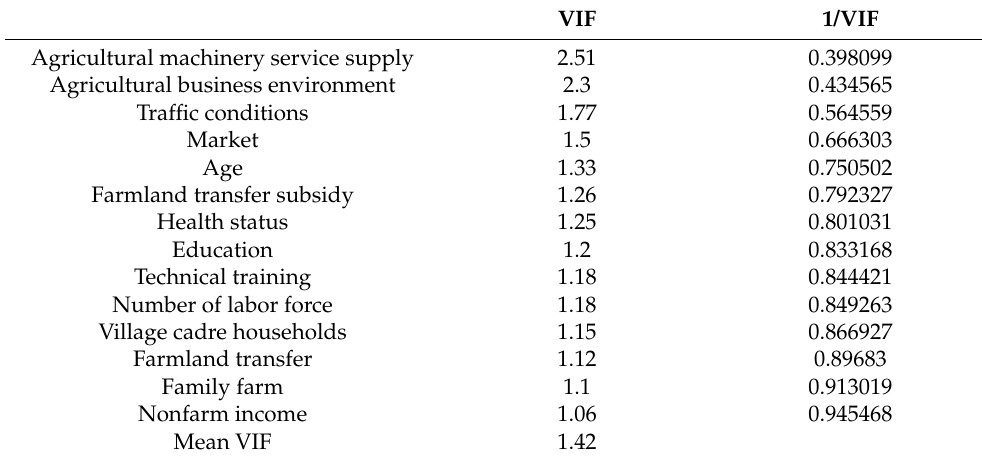
Table 2. Multicollinearity test of the model.